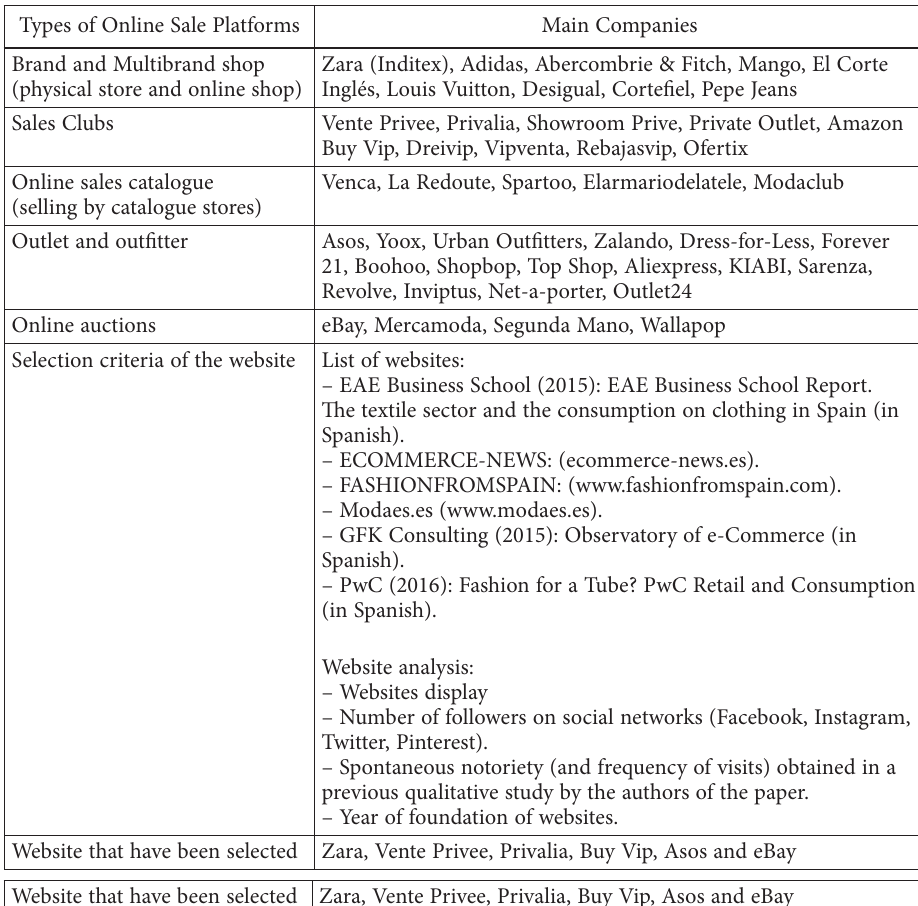
Table 2. Methodology for chose the websites